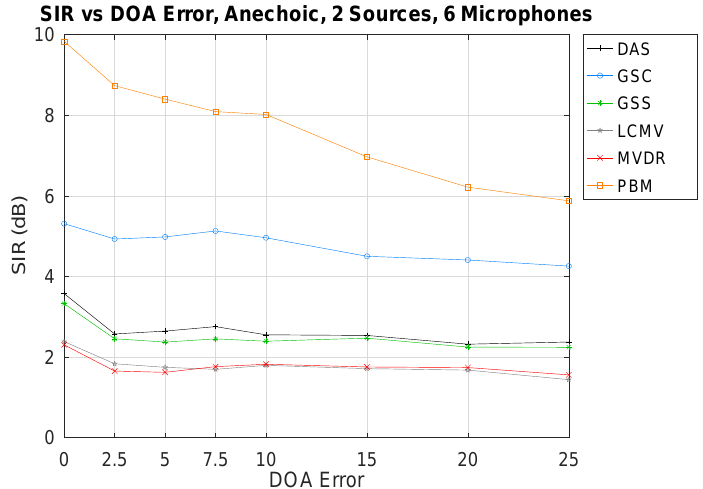
Figure 7. SIR vs. DOA error in the Anechoic Chamber.